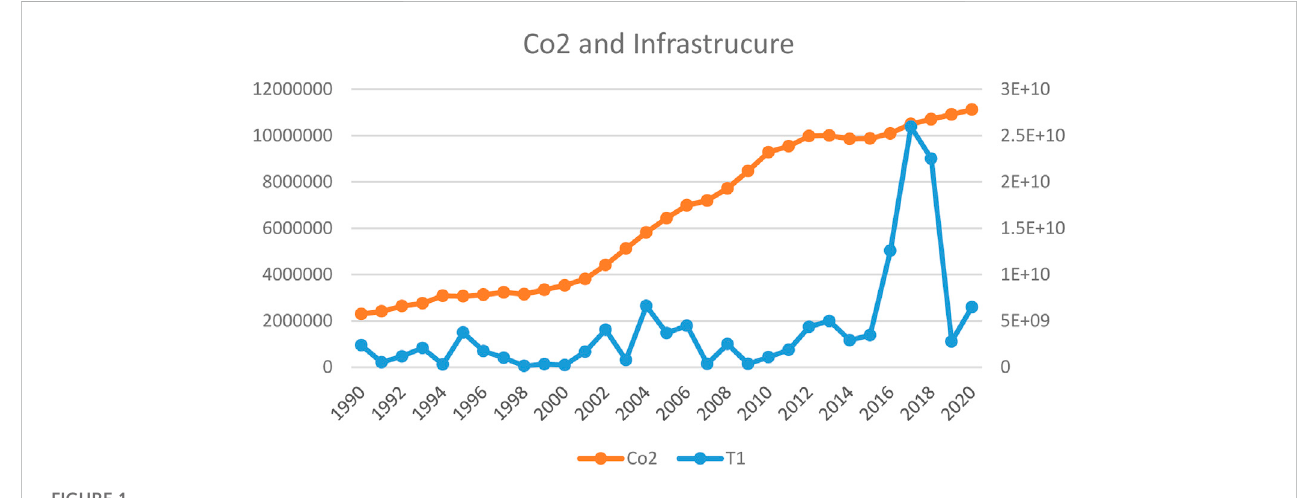
FIGURE 1 CO 2 emissions and Infrastructure.